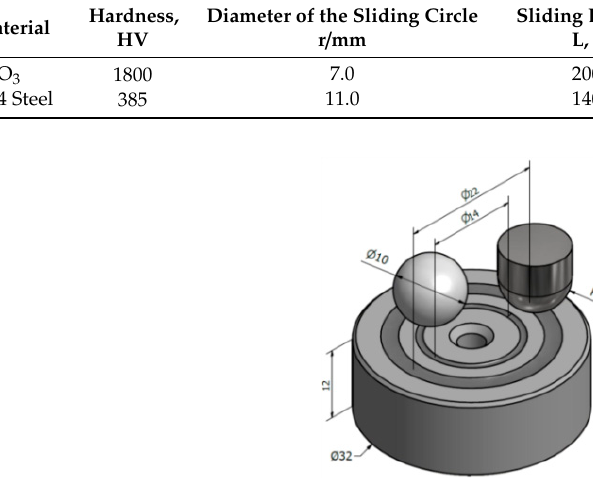
Table 3. Conditions for tribological tests carried out on the Vanadis 8 and Vancron 40 steel samples.